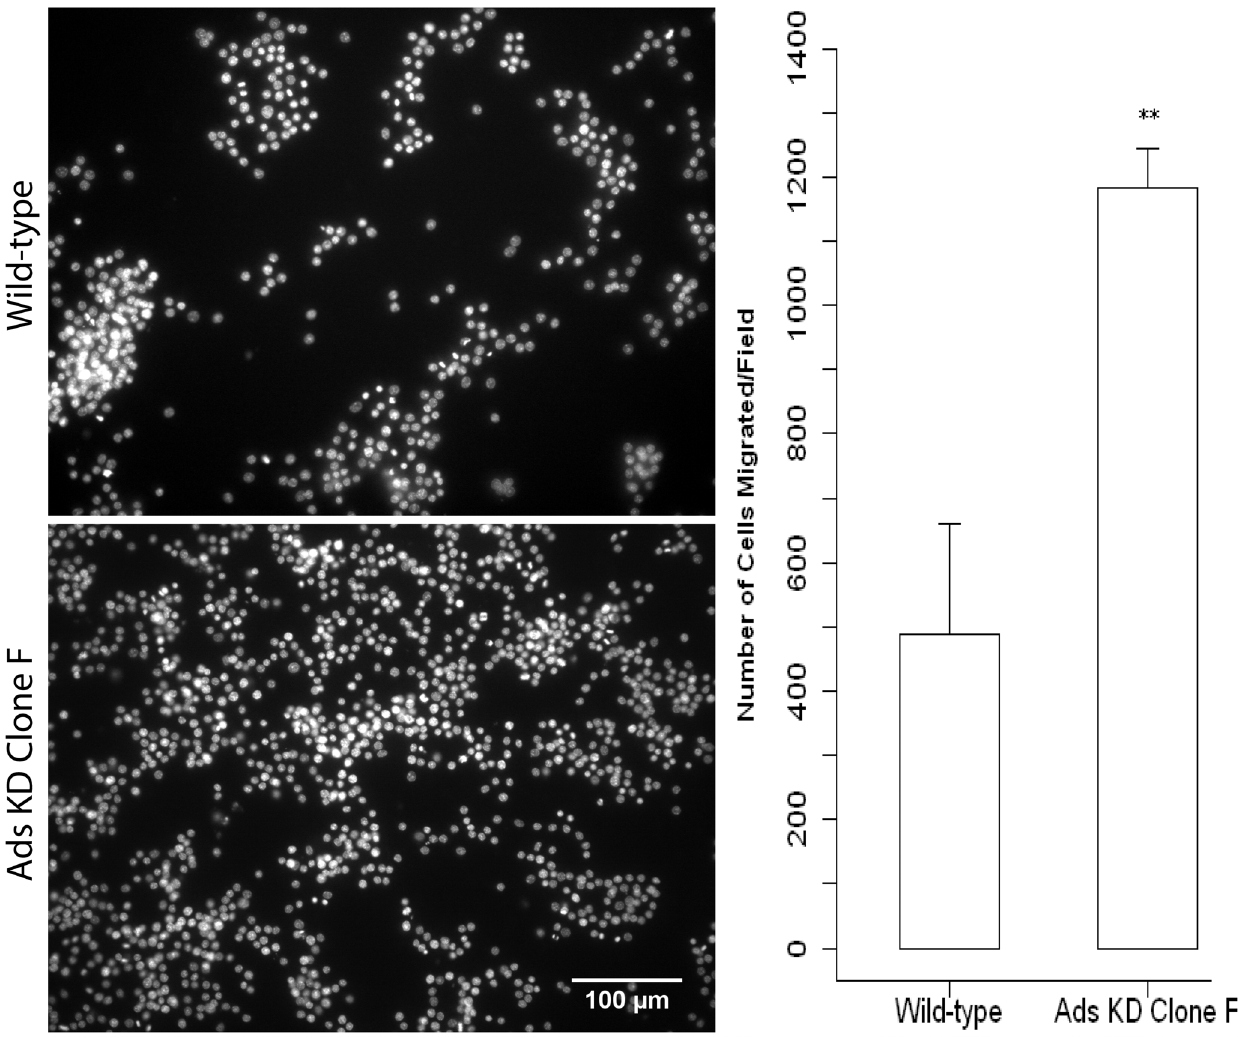
Figure 7. Adseverin knockdown osteoclast precursors display enhanced migration in response RANKL. 2 6 10 5 Day 2 sRANKL starved WT and Ads KD (Clone F) cells were seeded in transwells (8 m m) pre-equilibrated in reduced DMEM containing 60 ng/mL sRANKL. The cells were starved for RANKL and then incubated for 20 hours to allow for migration (chemotaxis). After migration, the non-migratory cells on the top of the membrane were removed and migration assessed by enumerating the cells on bottom of the membrane (n=3). Significantly more Ads KD Clone F cells migrated towards the chemokine sRANKL suggestive of enhanced migration ability in the absence of Ads.